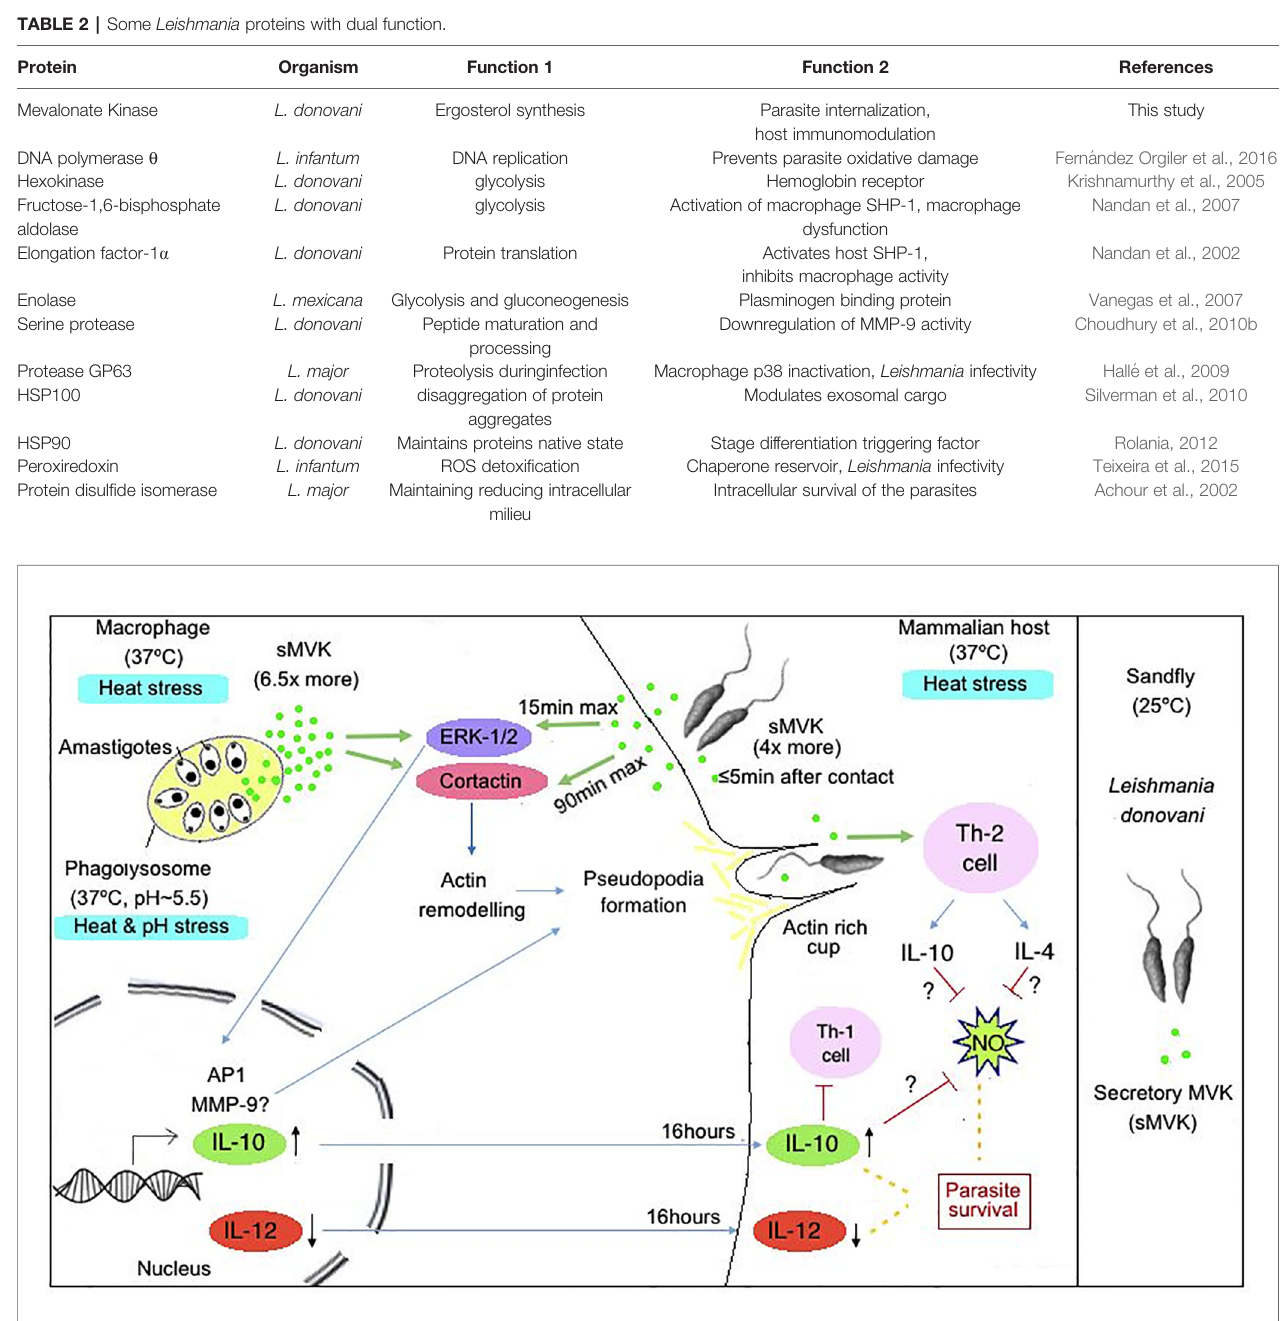
FIGURE 7 | Hypothetical model representing role of LdMVK in infection of macrophage by Leishmania . Exposure of Leishmania promastigotes to the human host (37°C) leads to increase secretion of MVK (four times more in comparison to parasites at 25°C). Further, Leishmania entry inside phagolysosome creates heat and pH stress (37°C, pH~5.5) conditions for the parasite, leading to further increase in MVK secretion (6.5 times more in comparison to parasites at 25°C). Secreted MVK (sMVK) activates host ERK-1/2 which leads to MVK-induced IL-10 production/secretion and suppression of IL-12 production/secretion. MVK also triggers release of IL-4 cytokines and show Th-2 dependent immune response causing immune suppression. Additionally, MVK triggers the activation of Cortactin, promoting actin rich cup formation facilitating parasite entry inside